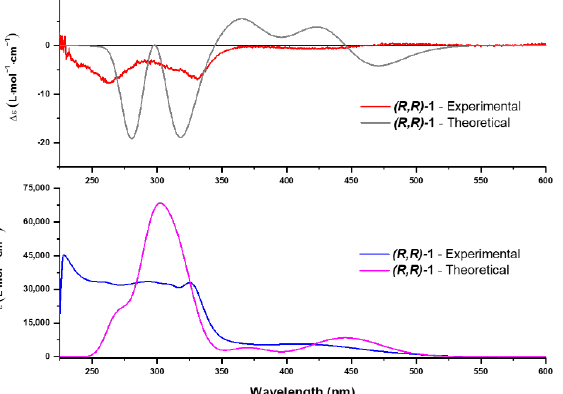
Figure 11. Experimental and theoretical (TD-B3LYP/Def2-SVPD) CD and UV-Vis spectra for neutral compound ( R , R )- 1 .